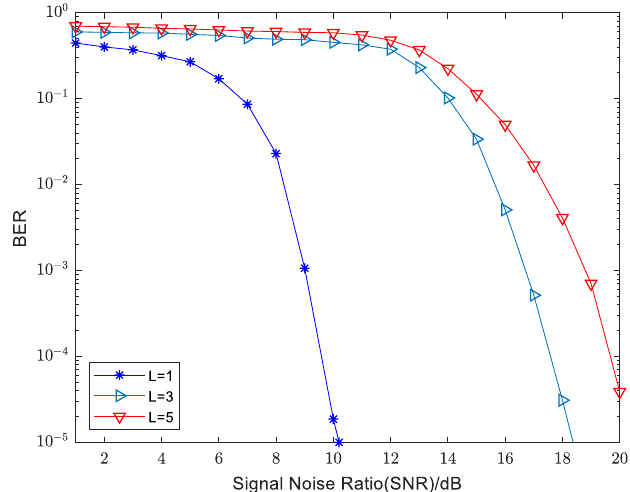
Figure 9. System BER performance for different transmission distances.